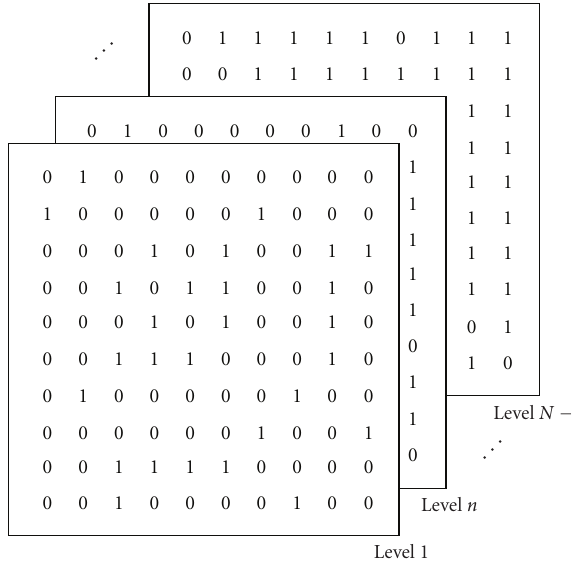
Figure 5: Di ff erent levels of adjacency matrix A n for a network of N = 10 nodes: nonzero values indicate that a link between two nodes ( i , j ) is possible in n steps.